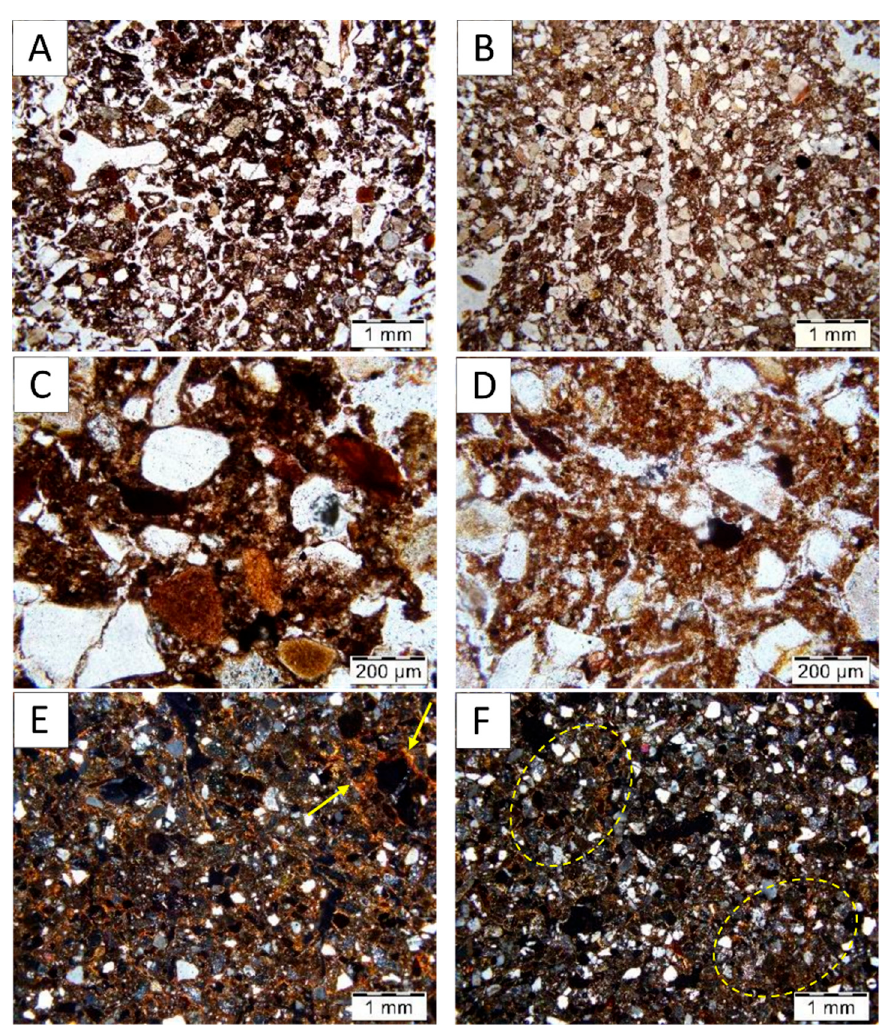
Figure 6. Microstructure and fine material features in the buried soil ( left — A,C,E ) and in the surface soil ( right—B,D,F ). ( A,B ) Microphotographs of the Ahb horizon (0–5 cm) of the buried soil with moderately separated granular microstructure ( A ) and the Ah horizon (3–8 cm) of the surface soil with weakly separated angular blocky microstructure ( B ); please note the difference in the color of the fine material; NII. ( C,D ) Microphotographs of the Ahb horizon (0–5 cm) of the buried soil with dark brown cluster-like fine material ( C ) and the Ah horizon (3–8 cm) of the surface soil ( D ) with brown fine material including small single dark particles and plant residues; NII. ( E,F ) Microphotographs of subsurface horizons. The Bwb horizon (20–25 cm) of the buried soil ( E ): fine material with high birefringence and poro-, granostriated b-fabric; please note thin clay coatings (marked by yellow arrows). The Bw horizon (30–35 cm) of the surface soil: scarce fine material and single spaced equal enaulic c/f related distribution; please note zones similar to the Bwb horizon groundmass (marked by dashed yellow ellipses); NX.